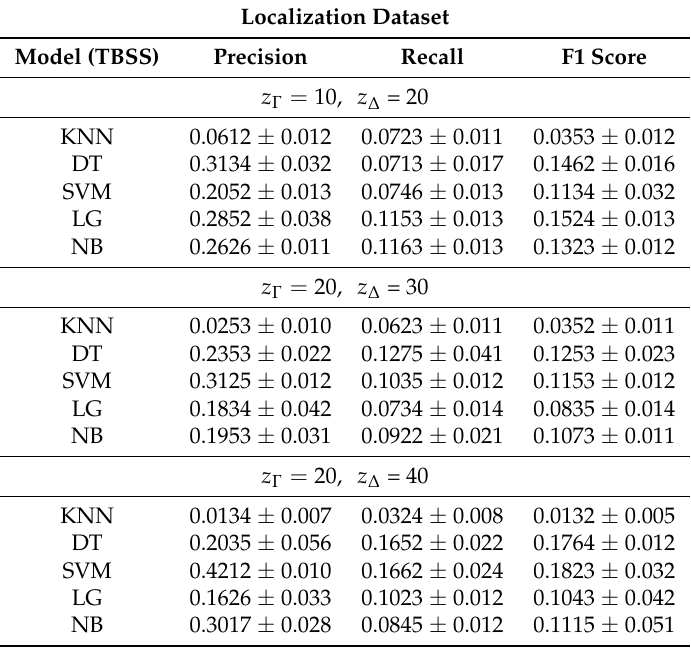
Table 5. Different size of subspace and its performance.